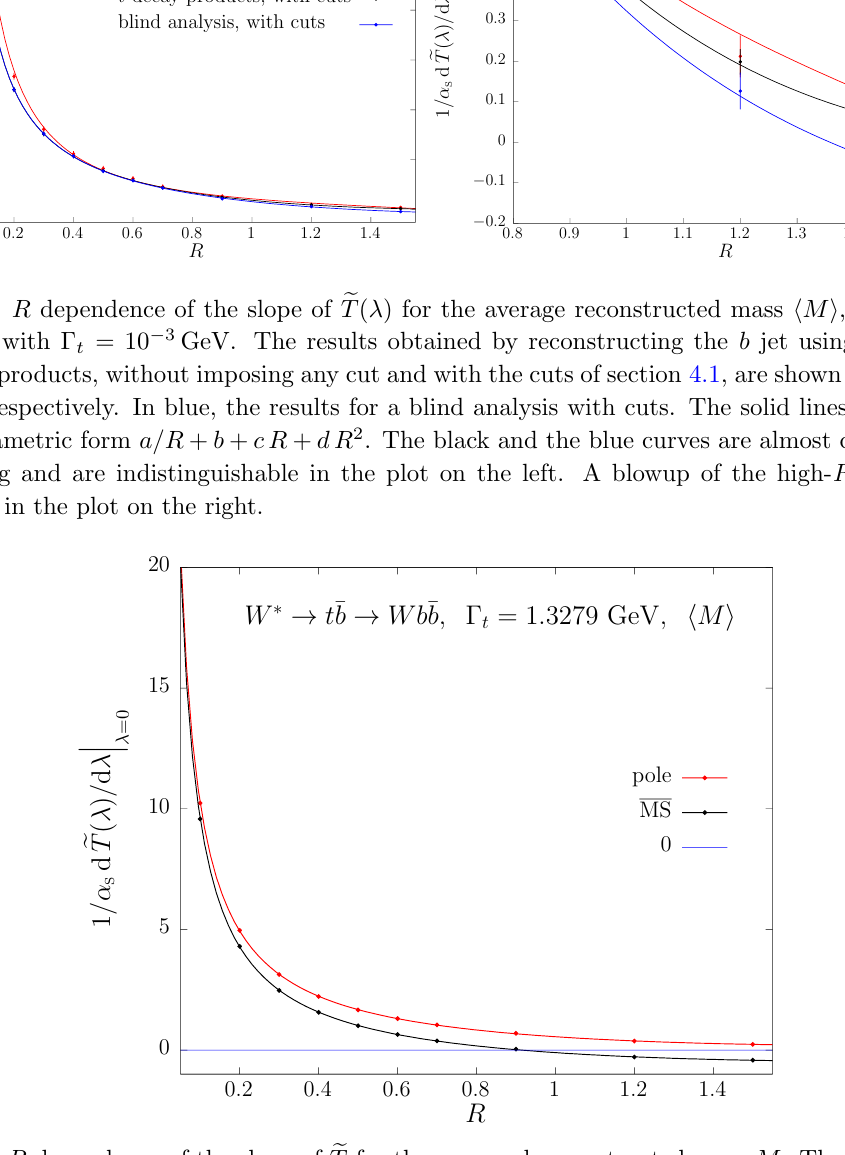
In (cid:12)gure 8 we plot the small (cid:21) behaviour of e T ( (cid:21) ) for the reconstructed-top mass, computed with the (cid:12)nite top width, for several values of the jet radius R . It is clear that our observable is strongly a(cid:11)ected by the jet renormalon. The same plot for only the three largest values of R is shown in (cid:12)gure 9. The (cid:12)gure shows clearly that the slope of e T ( (cid:21) ) for small (cid:21) computed with (cid:0) = 1 : 3279 GeV changes when (cid:21) goes below 1 GeV, that is to say, t when it goes below the top width. This behaviour is expected, since the top width acts as